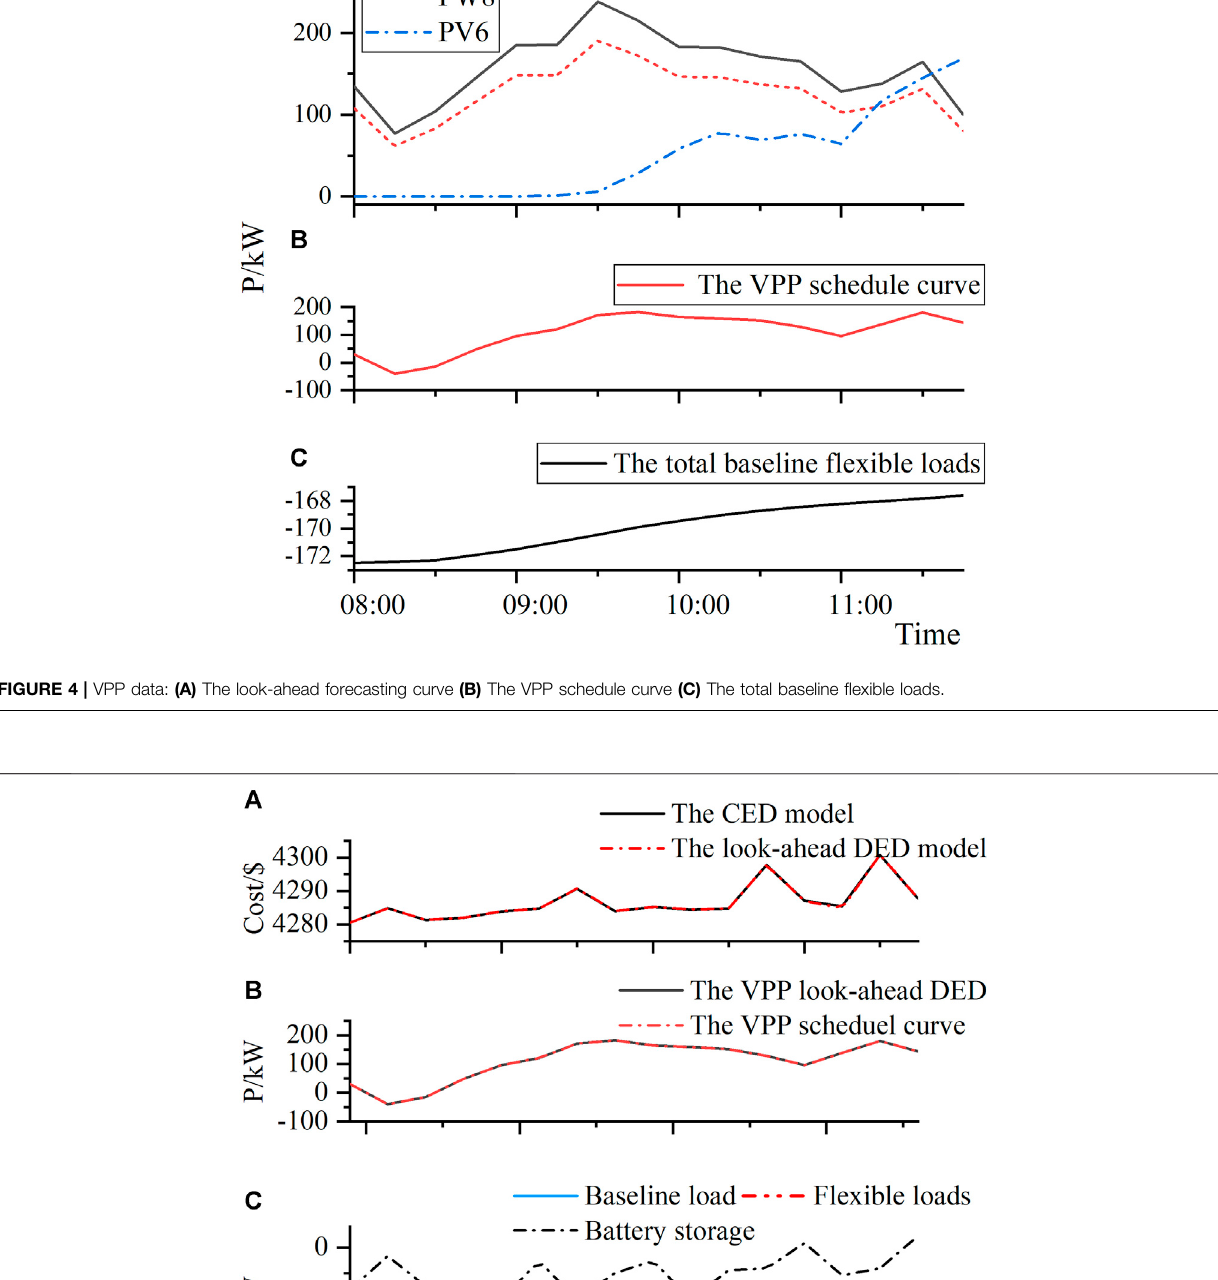
Frontiers in Energy Research |